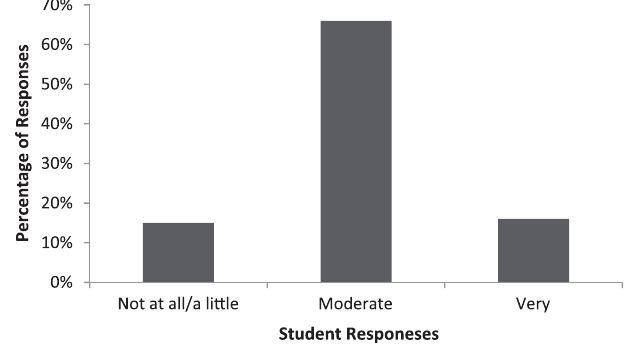
FIG. 5. Students ’ self-reported knowledge about science.